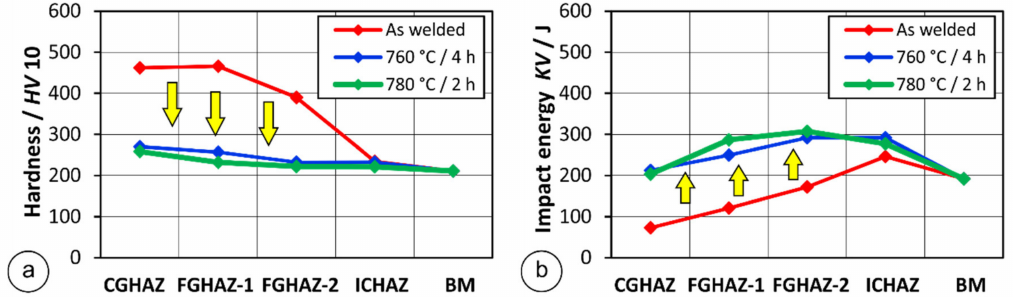
Figure 10. Change of ( a ) hardness and ( b ) impact energy upon recommendable